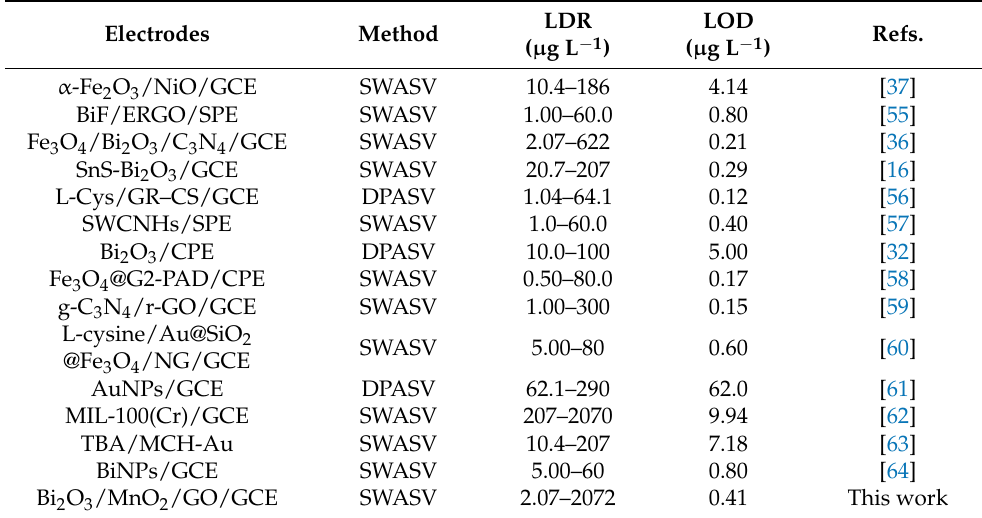
Figure 8. ( A ) The SWASV curves of Pb 2+ recorded on the Bi 2 O 3 /MnO 2 /GO/GCE in 10 mL of 0.1 M HAc-NaAc buffer (pH = 5.5) containing various concentrations of Pb 2+ ; the inner inset represents the magnification of the SWASV curves of Pb 2+ at low concentration (0.01 – 1.0 μ M). ( B ) A linear plot of the SWASV responses of Pb 2+ versus Pb 2+ concentration. Table 2. A comparison on the analytical properties for Pb 2+ determination.